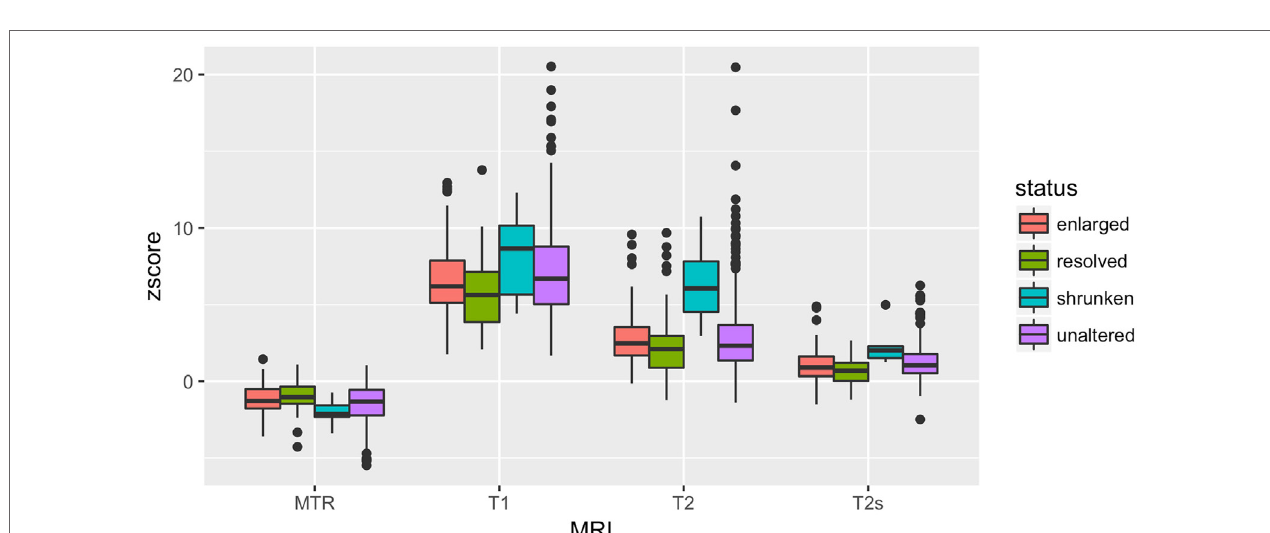
FigUre 5 | At baseline, T1, T2, T2* and MTR z-scores differences among stable, enlarged shrunken and resolved WM lesions.